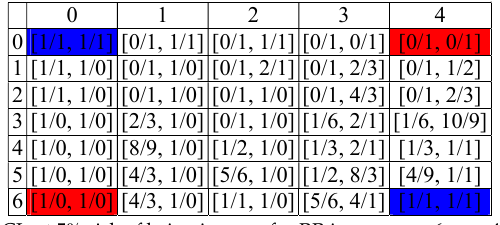
property of OR: OR( x , y , m , n ) · OR( m − x , n − y , m , n ) = 1.